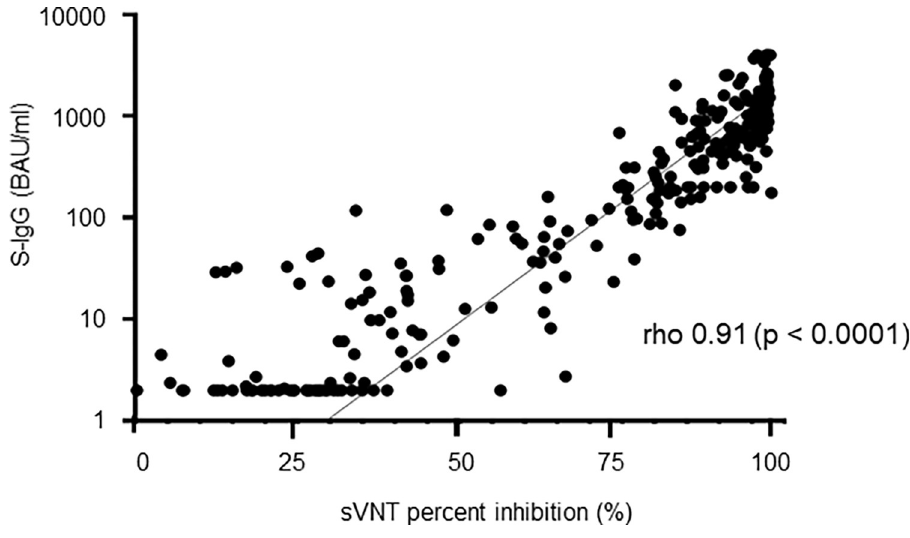
Fig 1. Comparison of VITROS S-IgG values and cPass sVNT titers.